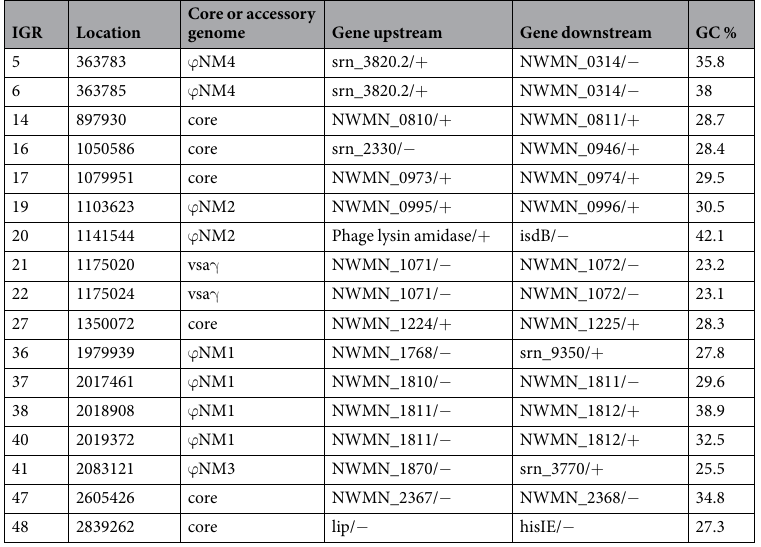
Table 2. Bioinformatic curation narrows the list of possible new sRNAs found in Staphylococcus aureus Newman strain to 17 candidates. The locations listed are based on coordinates in the Staphylococcus aureus Newman strain. Core and accessory candidates were determined based on the genome sequence published by Baba et al . 23